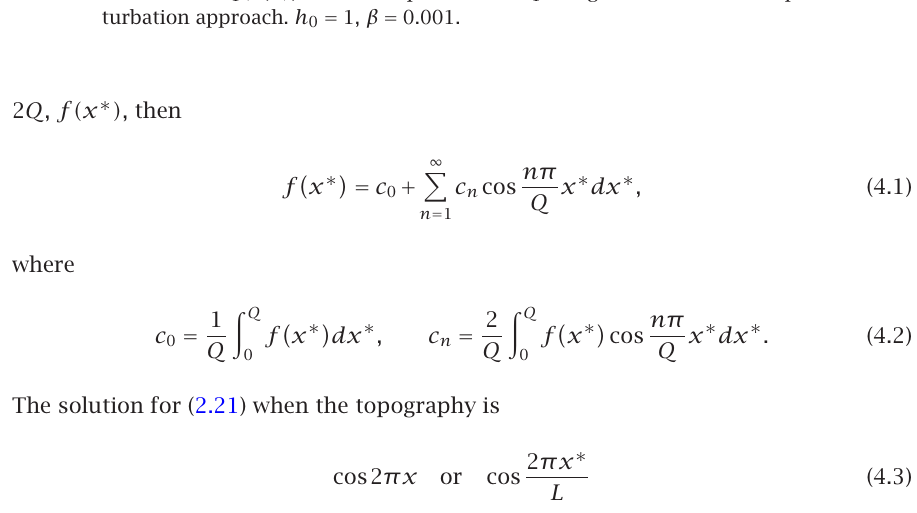
1 using Section 3.1.1 and a per-